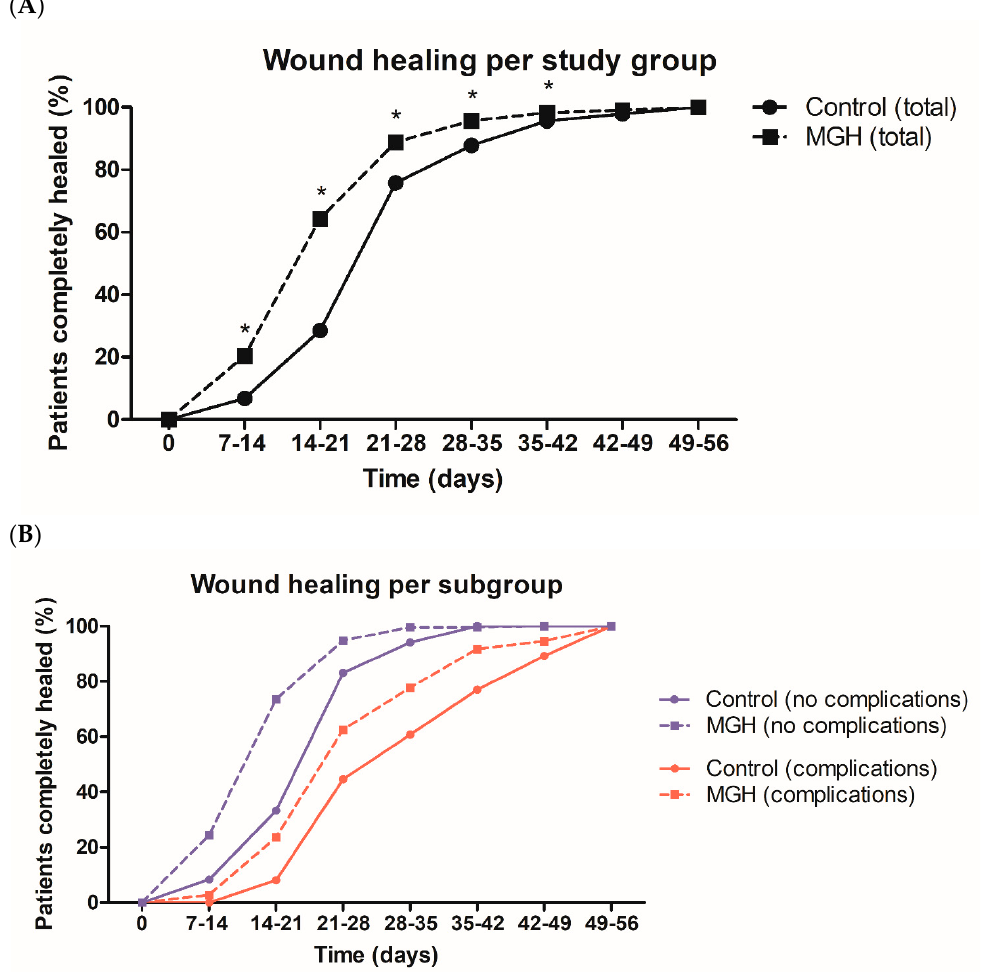
Figure 1. ( A ) Wound healing progression per study group. ( B ) Wound healing progression per sub- group (study groups divided into groups with and without complications). The control (sub)groups (antibiotics + povidone-iodine) are presented by solid lines and circles, and the treatment (sub)groups (MGH) are presented by dashed lines with squares. Purple lines represent the subgroup without complications and red lines the subgroups with complications). An asterisk (*) above the line represents a significant difference between the groups at that certain time point. Table 8. Overview of wound healing time per suture technique (simple interrupted, vertical mat ‐ tress, and subcuticular). The percentages represent the distribution over the two study groups for the specific suture technique.